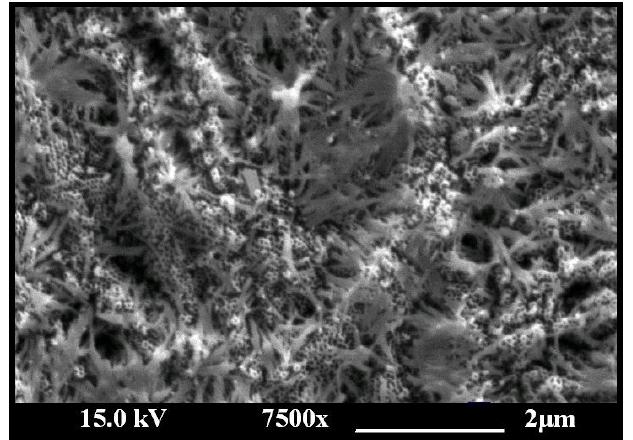
Fig. 2. Surface morphology of the TiO in the two-step anodization process and treated in a methanol solution under UV light